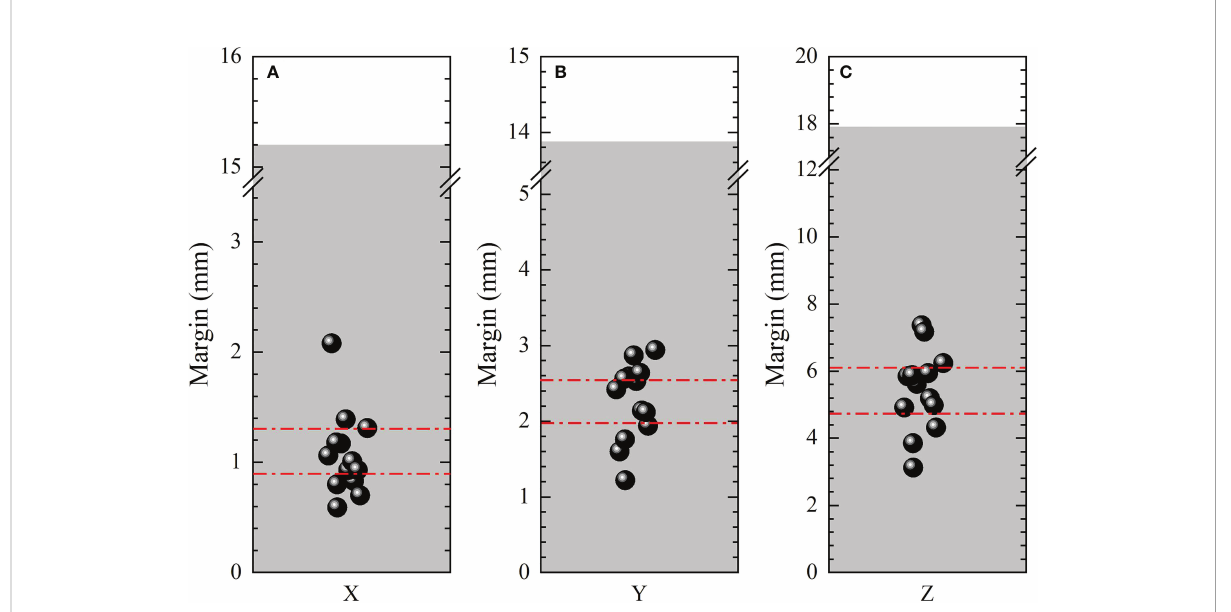
FIGURE 5 Comparison of anisotropic PTV margins in LR ( X ), AP( Y ) and SI ( Z ) directions between this work and that from M. Sharma ’ s work. The black solid balls and red dashed lines represent the PTV margins and related 95% con fi dent intervals obtained in this work. The gray areas indicate the range of margins from M. Sharma ’ s work